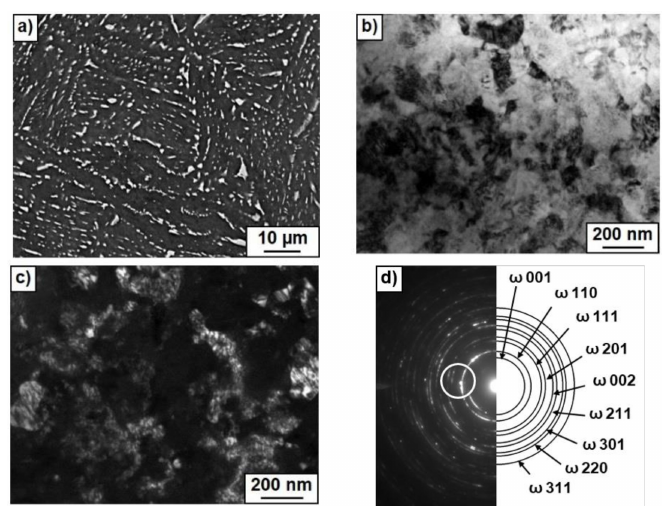
Figure 5. Microstructure of Ti–4 wt.% Co alloy after annealing at 600 ◦ C and and high pressure torsion (HPT). ( a ) Scanning electron microscopy (SEM) micrograph. ( b ) Bright field and ( c ) dark field transmission electron microscopy (TEM) micrographs after annealing at 400 ◦ C and following HPT. ( d ) Selected area electron diffraction